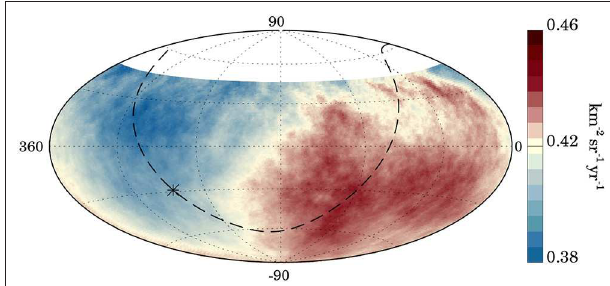
FIGURE 1 | Smoothed cosmic-ray flux for E Auger > 8EeV in equatorial coordinates. The dashed line and the star indicate the Galactic plane and center, respectively. Reproduced with permission from Aab et al.